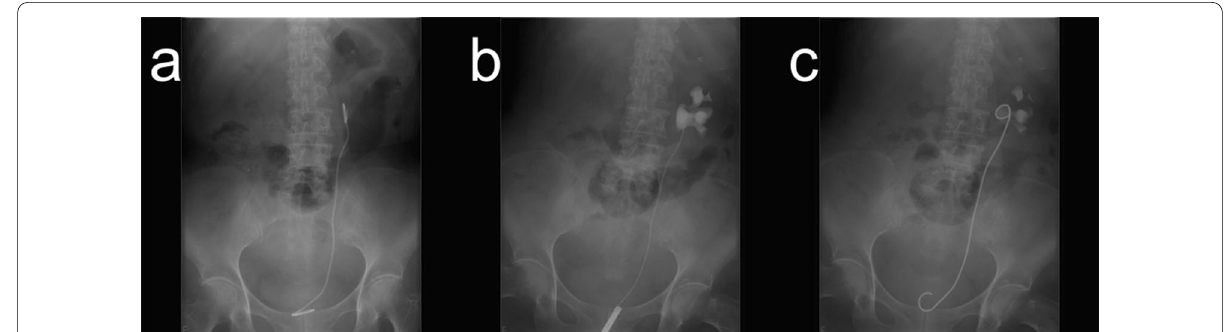
Fig. 3 a One month after placement of the polymer ureteral stent. b We performed retrograde pyelography again if re-evaluation was considered necessary, such as for a tortuous ureter noticed at the initial stent placement. c We confirmed that the proximal curl of the stent was located in the renal pelvis, and the distal curl was located in the